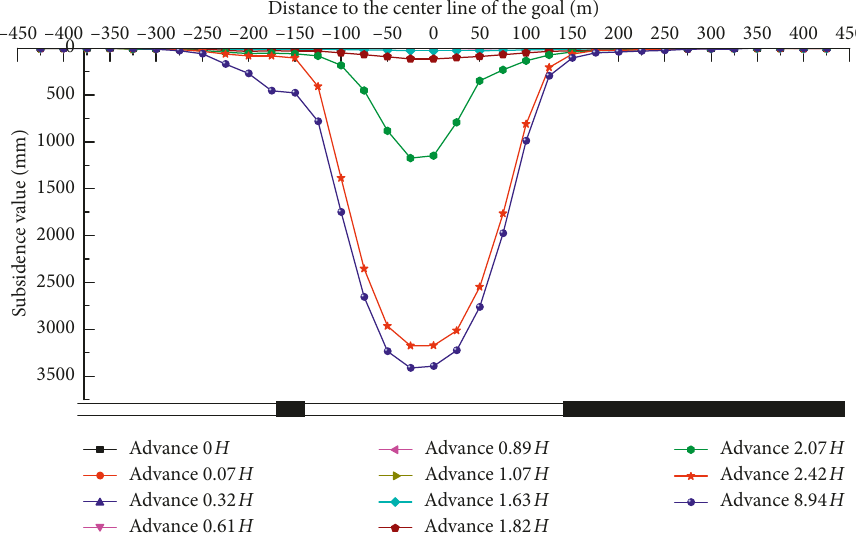
Figure 5: Dynamic subsidence curves of transverse